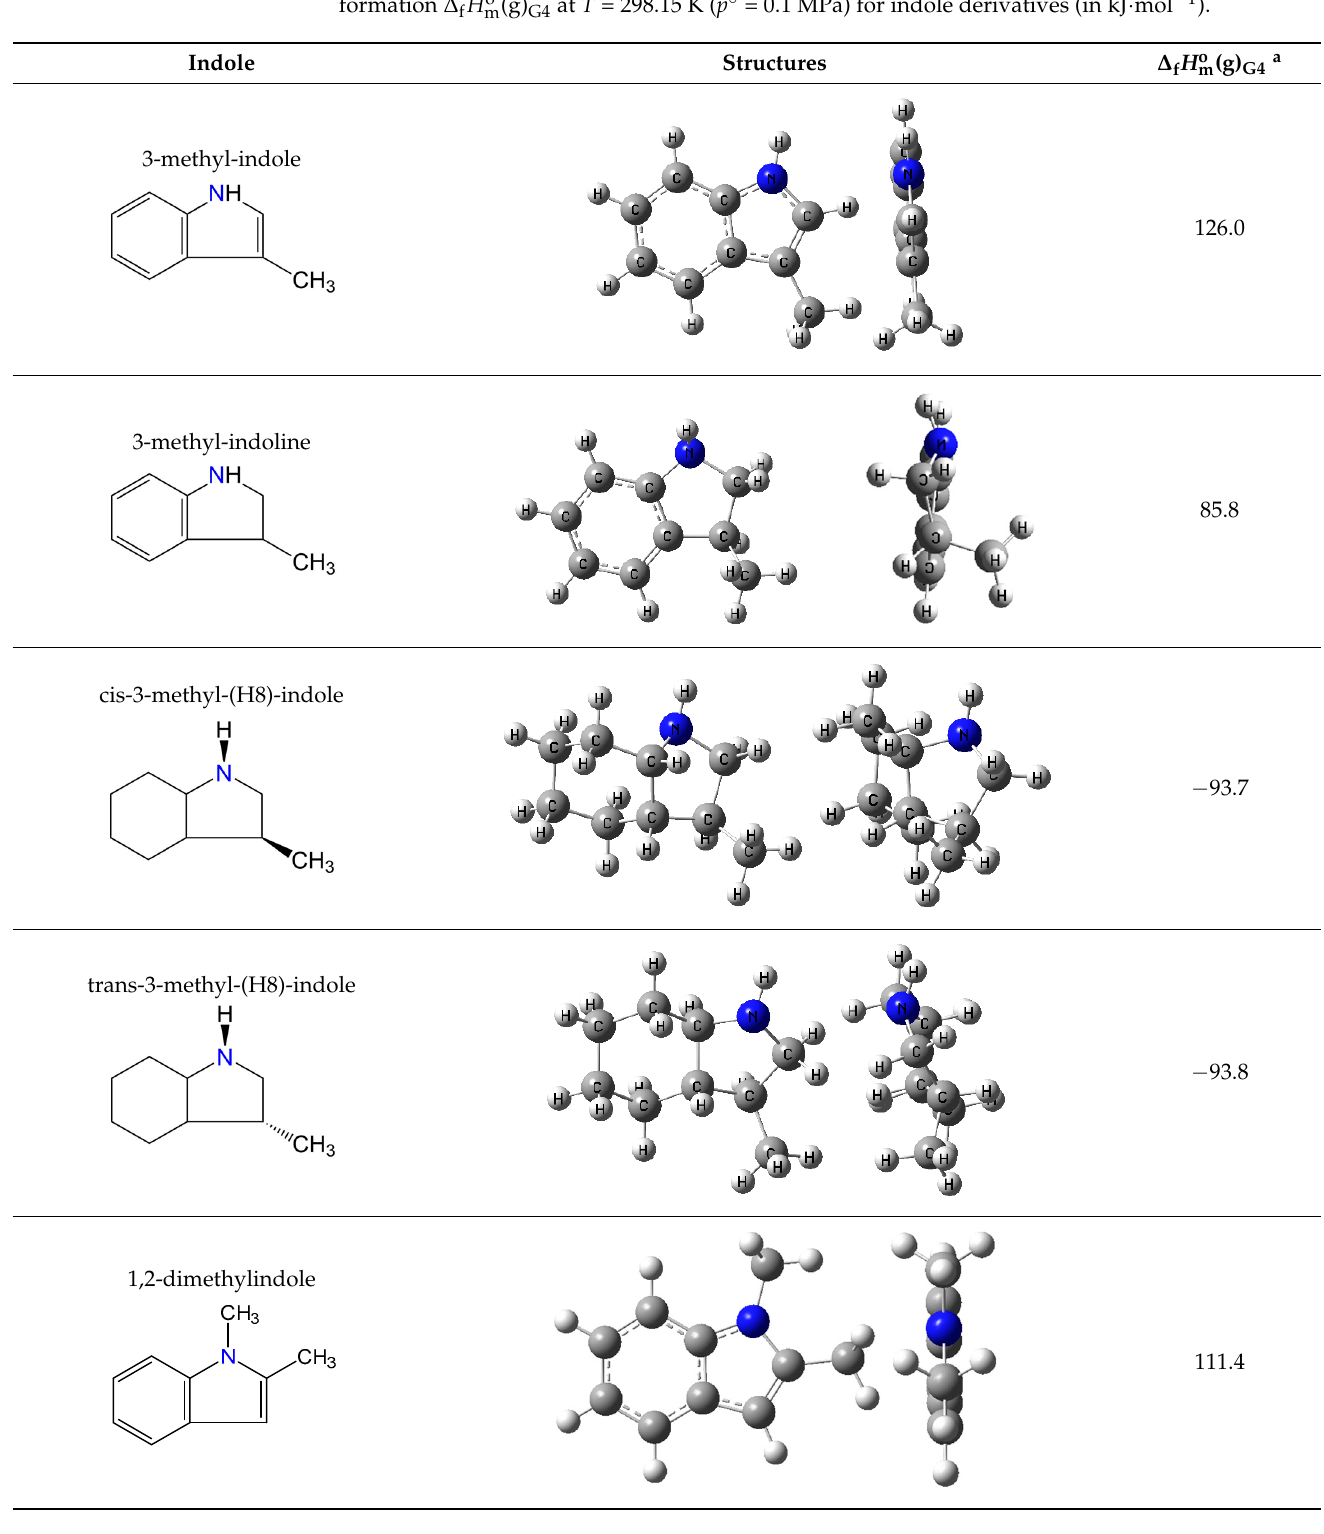
Table 3. Structures of the most stable conformers and the G4 calculated gas-phase enthalpies of